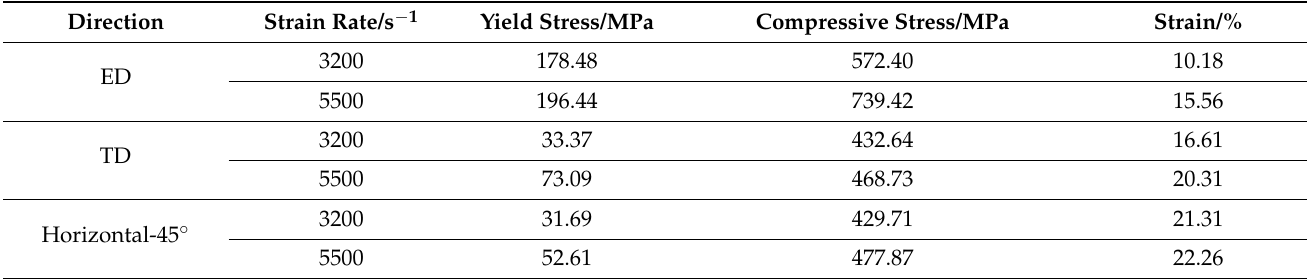
Table 1. Mechanical properties of Mg-Al-Ca-Mn alloy under high strain rate